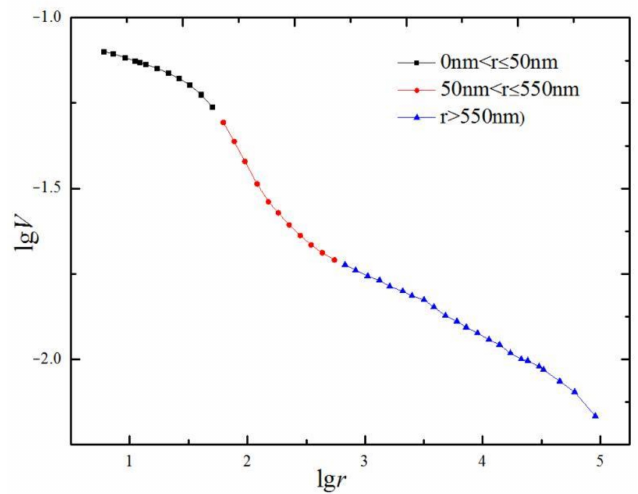
Figure 11. Relationship between Lg r and Lg V of fly ash